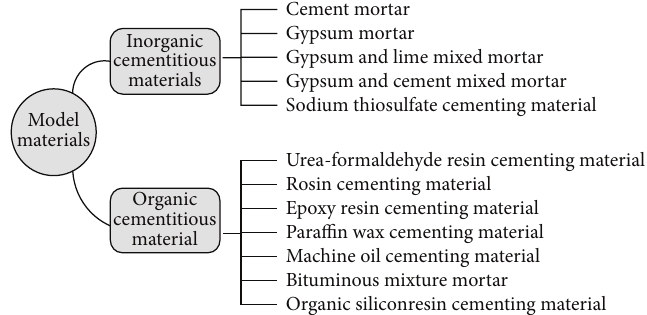
Figure 1: Classification of analogue materials for rock